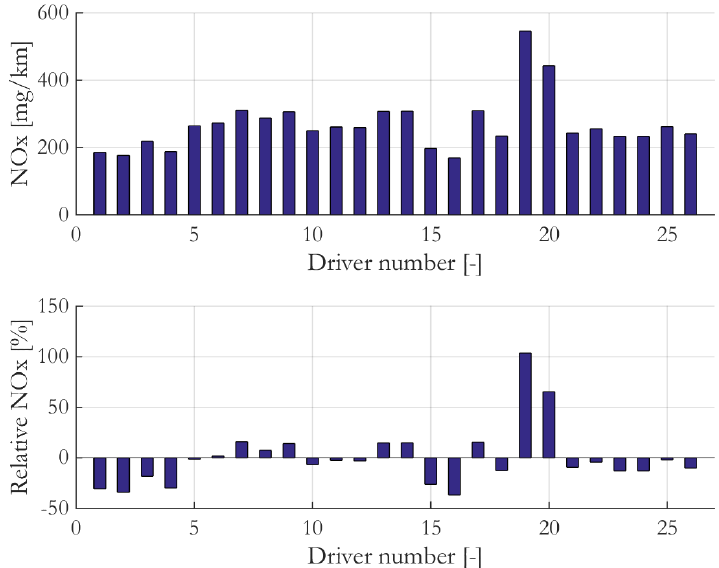
Figure 10. Example of NO x sensitivity on a sample of 26 drivers, on a same trip with the same vehicle (Diesel